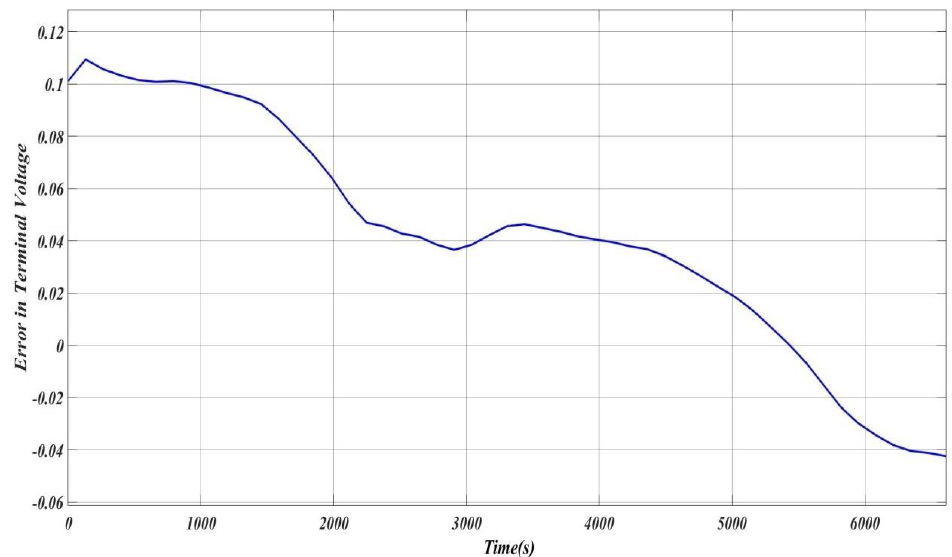
Figure 10. SOC vs. Time for pulse discharge.